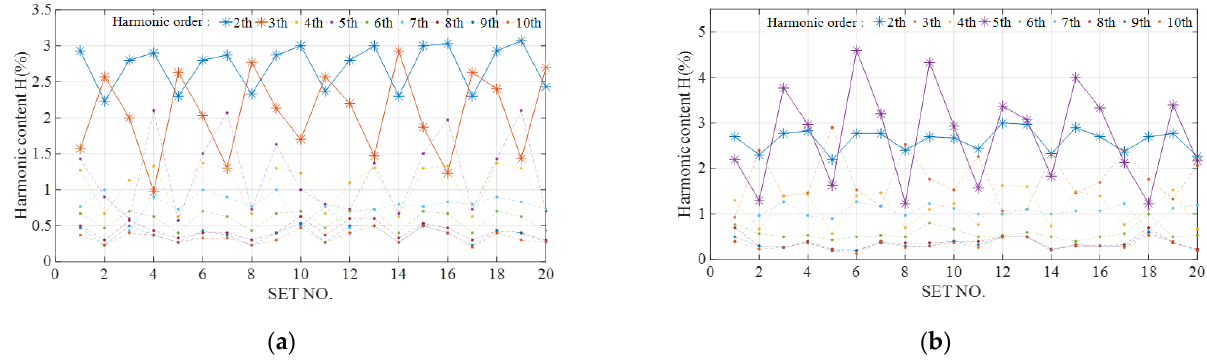
Figure 9. Test Data: ( a ) The twenty 20 sets of harmonic data statistics for line 1; ( b ) The twenty sets of harmonic data statistics for line 2.